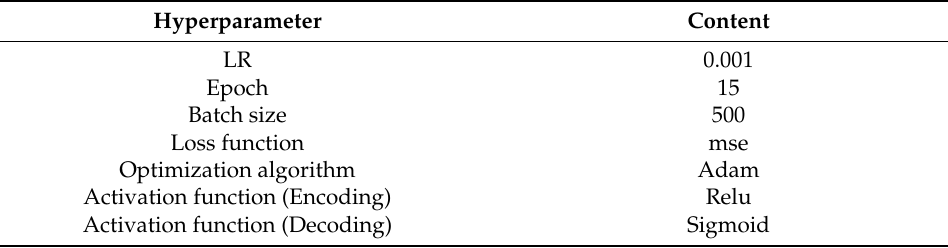
Table 3. Flow types and their